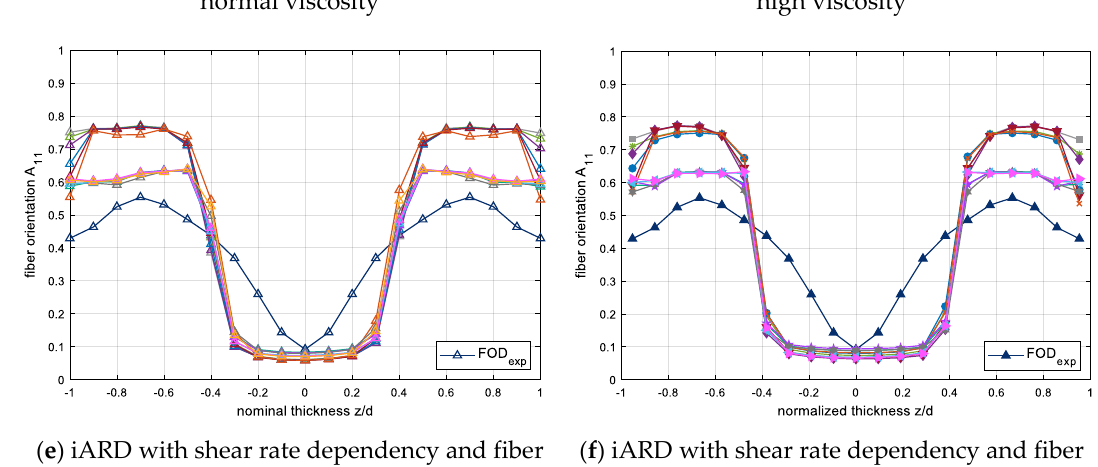
Figure 22. Influence of the viscosity for different fiber orientation model versions for PP-LGF20v30.